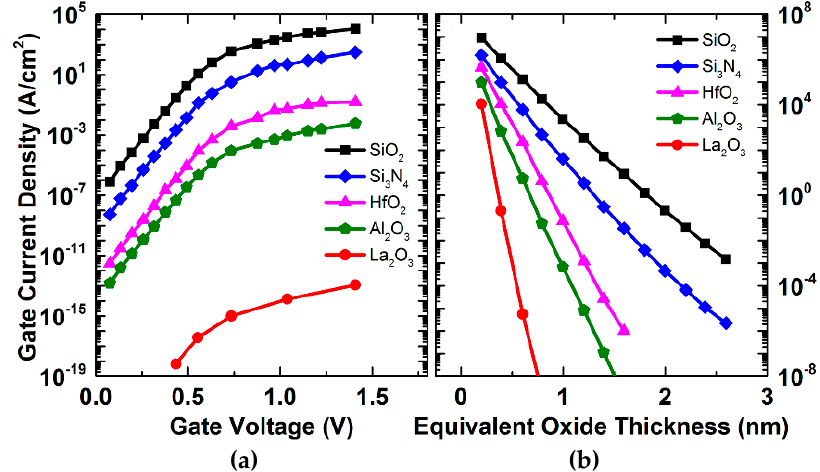
Figure 4. Gate leakage vs. ( a ) gate voltage and ( b ) equivalent oxide thickness for ideal MOS devices with different gate dielectrics [32].